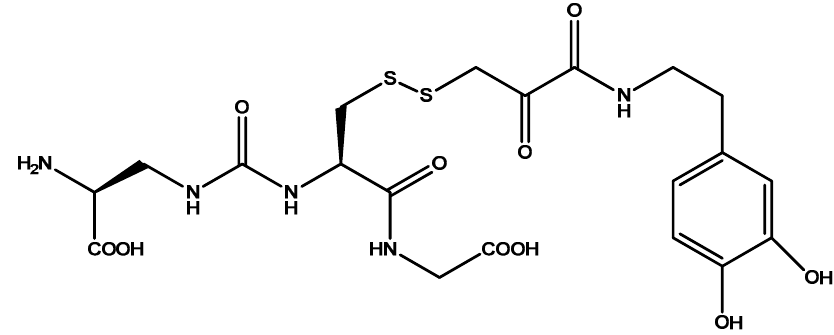
Figure 6. Glutathione conjugated prodrug of dopamine.